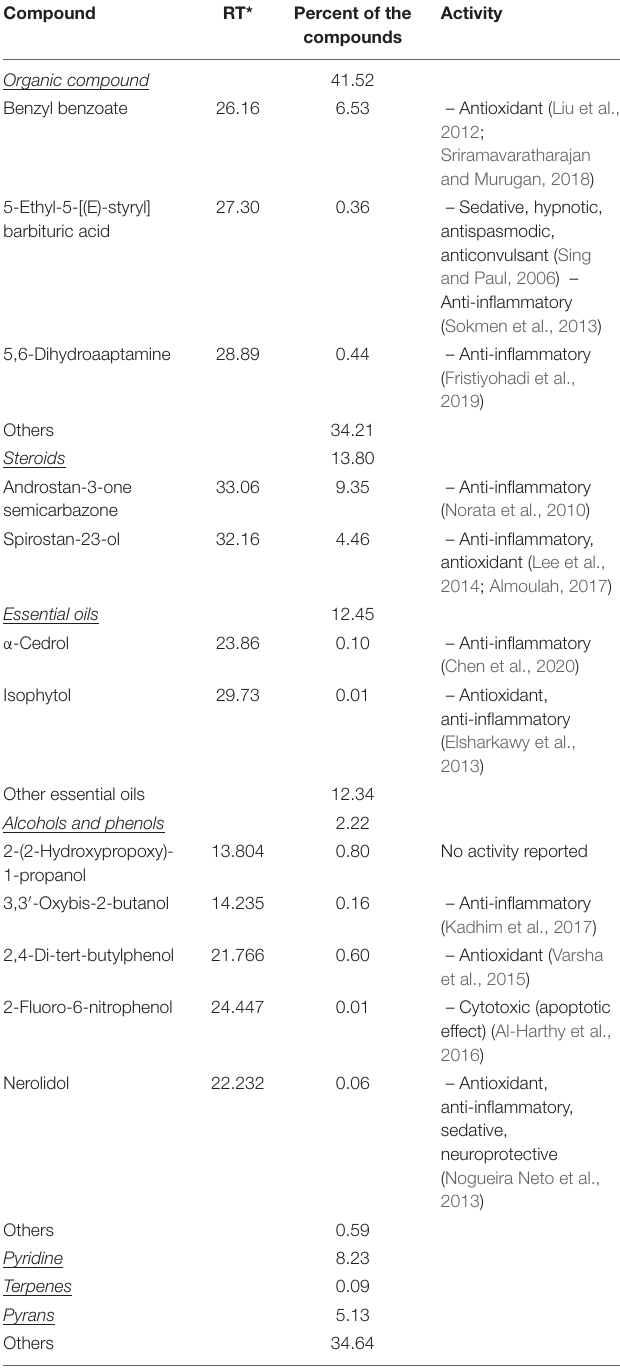
TABLE 1 | Compounds of musk identified using gas chromatography and mass spectrometer analysis. Compound RT* Percent of the compounds